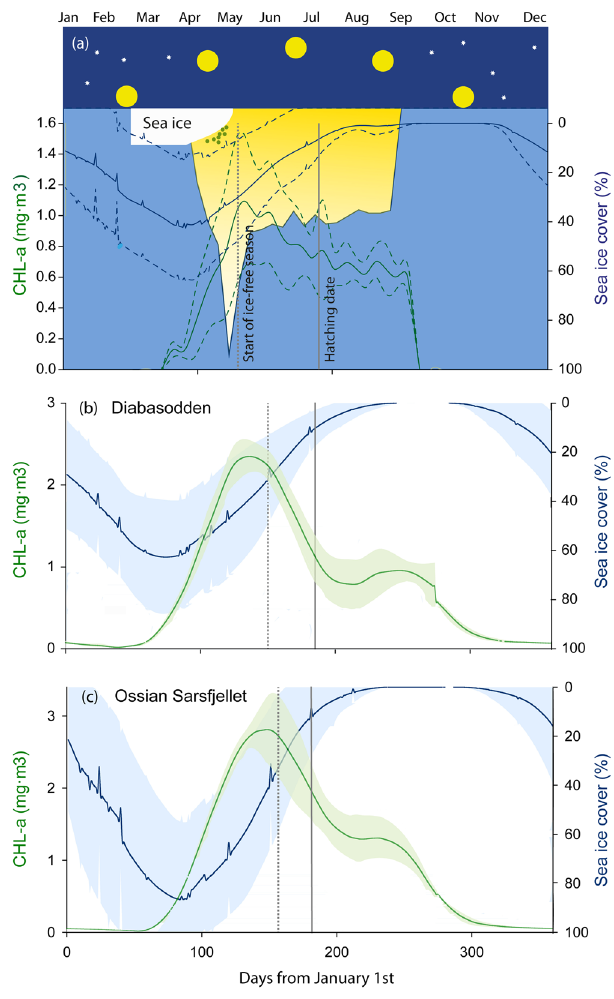
Figure 2. Environmental cycles in the seasonal ice zone. Principal processes regulating marine productivity within little auks ( a ) and Brunnich’s guillemots ( b , c ) foraging grounds (modified from Wassmann et al . 10 ). Annually averaged (2007–2016 for little auks and 2011–2016 for Brunnich’s guillemots) seasonal trends for sea- ice extent and chlorophyll- a (CHL- a ) have been used to pinpoint the annual blooms of sea ice algae and pelagic phytoplankton. KD490 (background colors in – a –) represents the capacity of light to penetrate into the water column (yellow area). 30% sea ice cover (dashed vertical line) has been used as a suitable threshold delimiting the sea ice season 6, 7 . The dark period, the height of the sun, the changing thickness of ice and the annual bloom of sea-ice algae are schematically shown in ( a ). Mean hatching dates (solid vertical lines) for each species are also